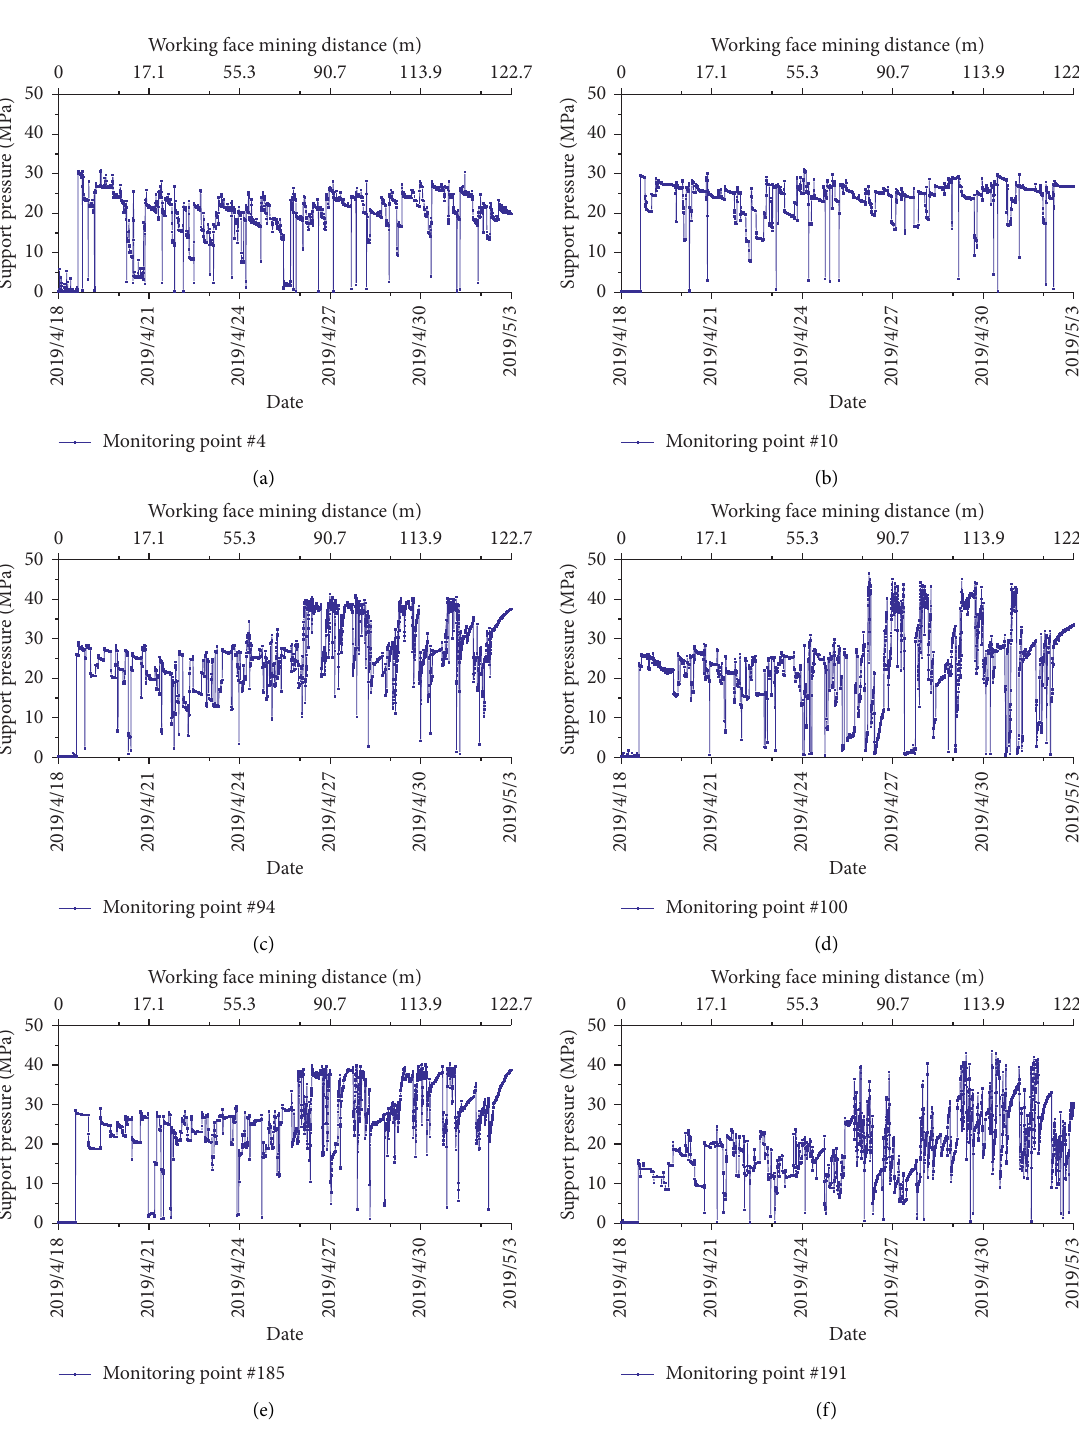
Figure 4: Working face support pressure curves monitoring point of (a) #4, (b) #10, (c) #94, (d) #100, (e) #185, and (f)